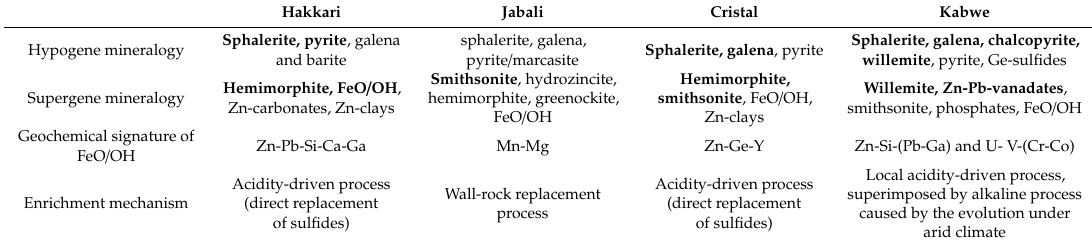
Table 3. Summary of features and findings on the mineral chemistry of Fe-oxy-hydroxides in the studied deposits. The dominant phases in the mineralogical assemblages are reported in